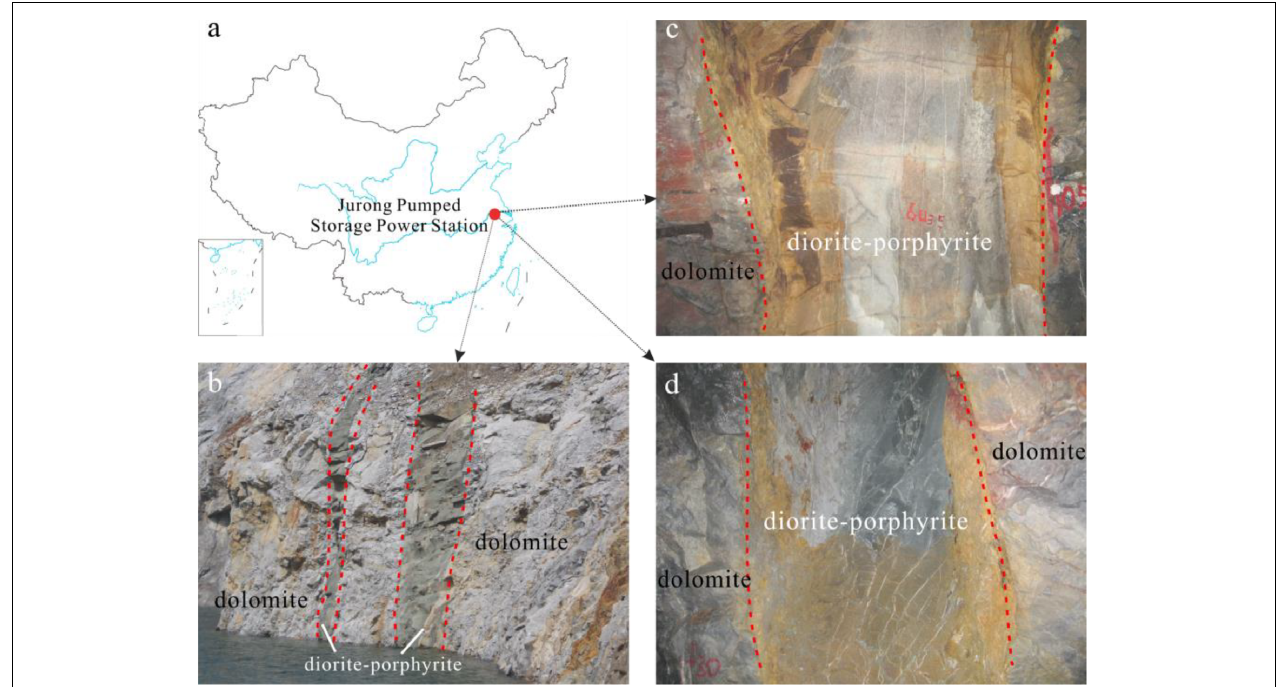
FIGURE 1 | (a) Geological location of Jurong pumped storage power station. (b) Weathered diorite-porphyrite on the ground. (c) Weathered diorite-porphyrite in the exploratory tunnel PD2. (d) Weathered diorite-porphyrite in the exploratory tunnel PD4.